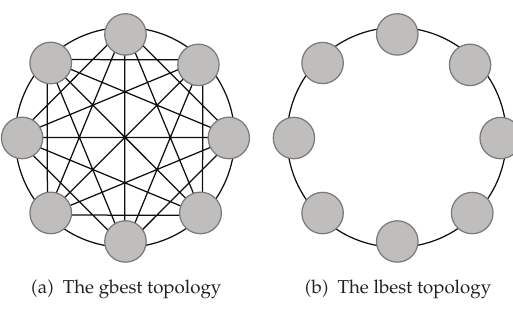
Figure 6: Two topologies of